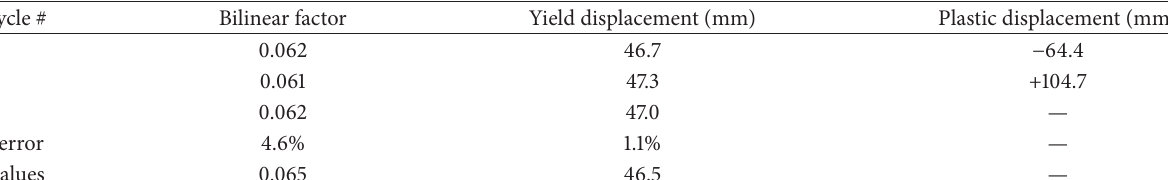
Table 3: Estimated structural performance parameters from multiphase linear regression analysis.